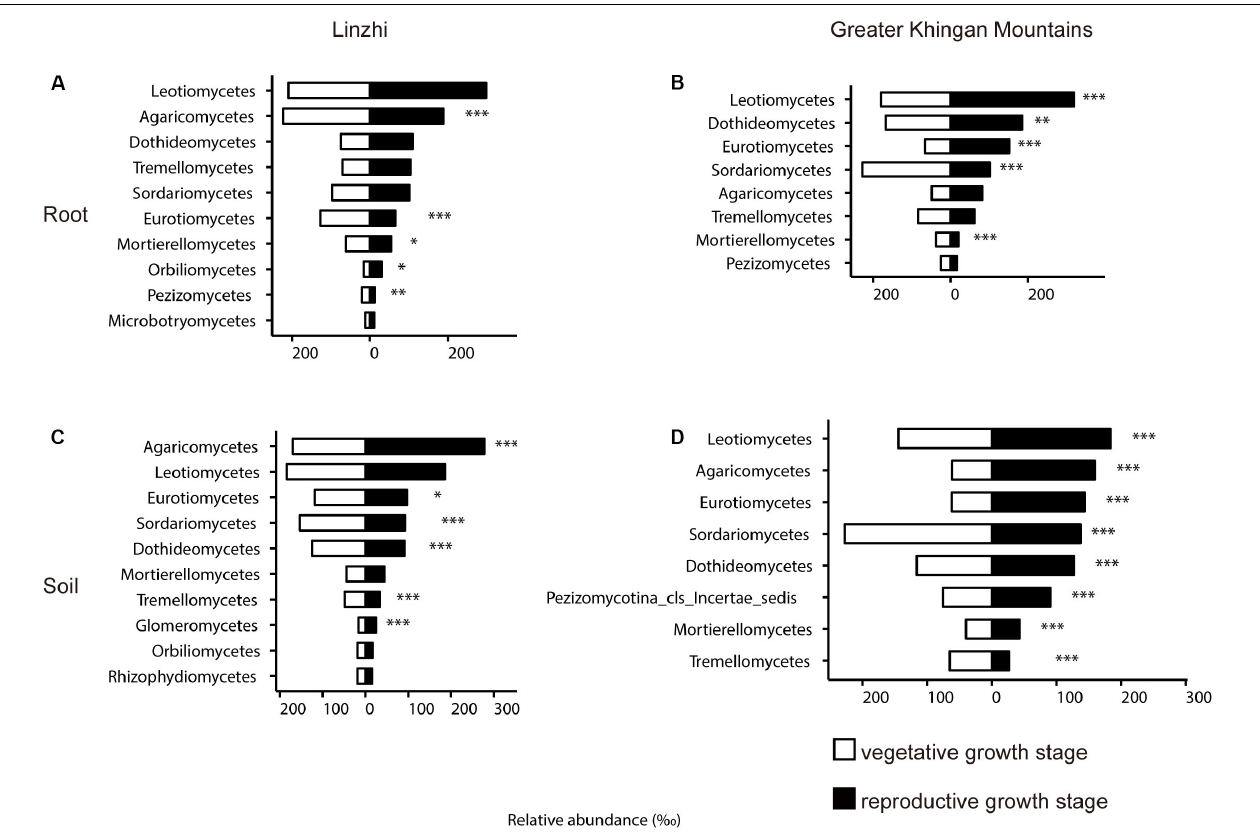
) of classes which made up at least > 10 (cid:104)